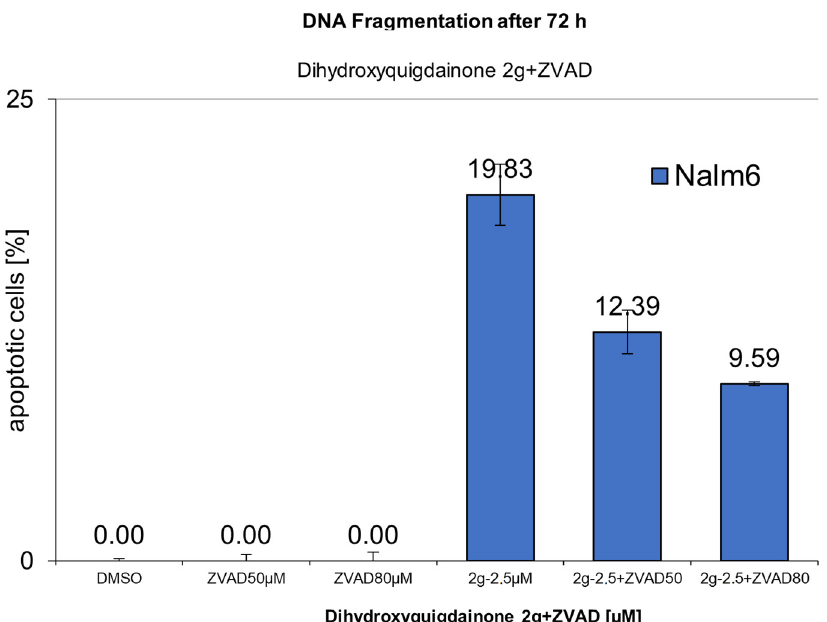
Figure 7. The apoptosis induction of 2g is caspase-dependent. Nalm-6 cells were treated with two concentrations of the pan-caspase inhibitor Z-VAD, with 2g and with 2g together with two concentrations of the pan-caspase inhibitor Z-VAD for 72 h. As the solvent, control cells were treated with the same amount of DMSO as used for 2g . After treatment, the induction of apoptosis was measured via flow cytometric analysis of DNA fragmentation. Three replicates were carried out per concentration. The mean values ± SD are shown ( p < 0.05 vs. corresponding concentration in Nalm-6, t -test). The pan-caspase inhibitor Z-VAD is able to inhibit the 2g -induced apoptosis significantly. Z-VAD alone do not induce apoptosis. These data demonstrate that dihydroxyquingdainone 2g -induced apoptosis is dependent on the activity of caspases in tumour cells.